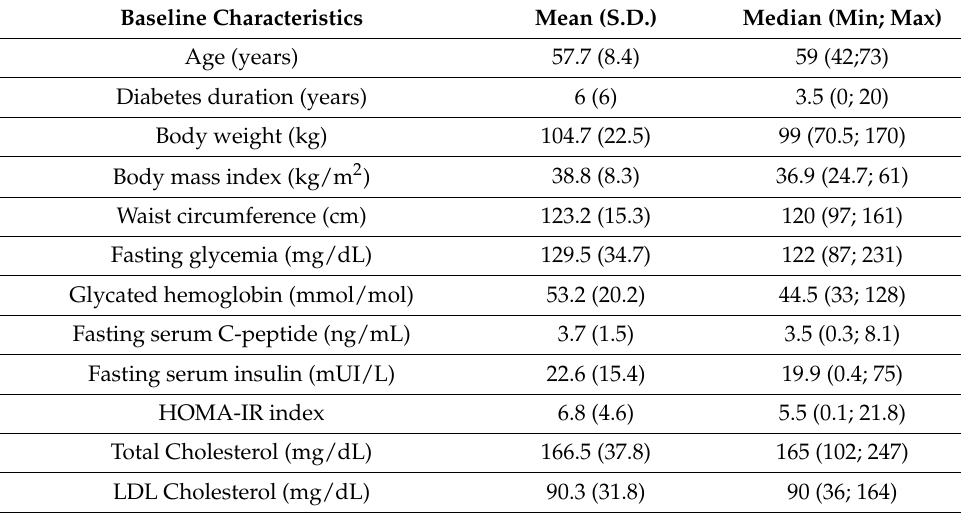
Table 2. Baseline characteristics of the study population (n =